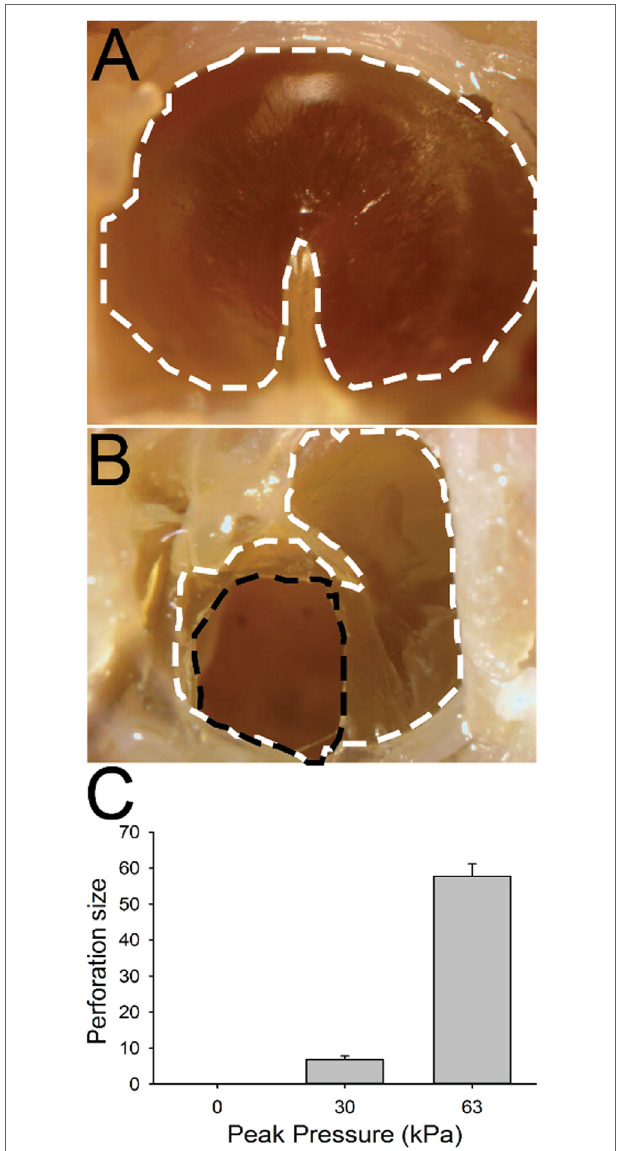
FigUre 6 | Tympanic membrane (TM) perforation. (a) Control animal. The TM is outlined with a white dashed line. (B) TM 1 h after 63 kPa blast-wave exposure. The dotted black line indicates blast-wave damage region. (c) Perforation size (normalized percent of total area) in blast vs control animals as a function of blast intensity. Scale bar = 1